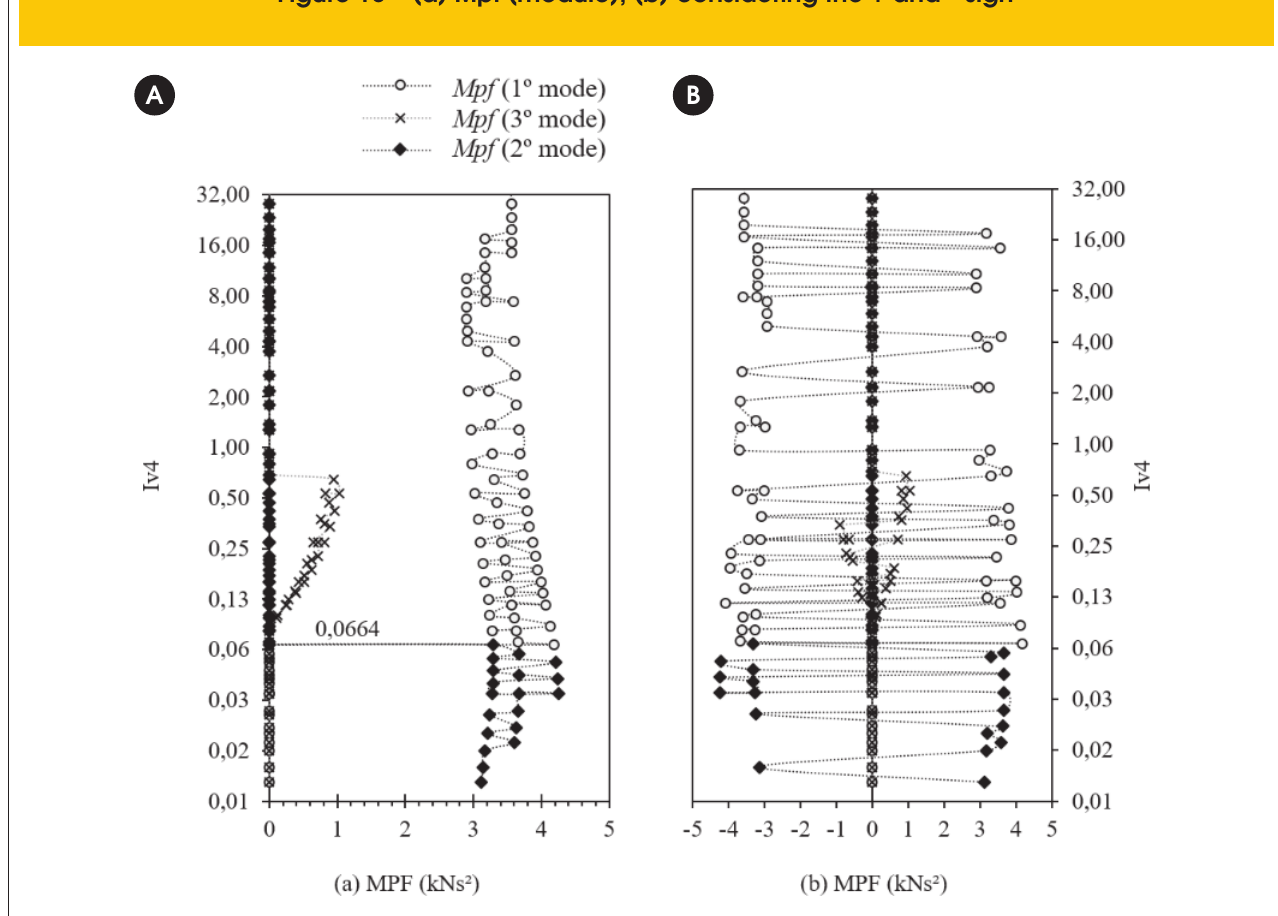
Figure 13 – (a) Mpf (module); (b) considering the + and -